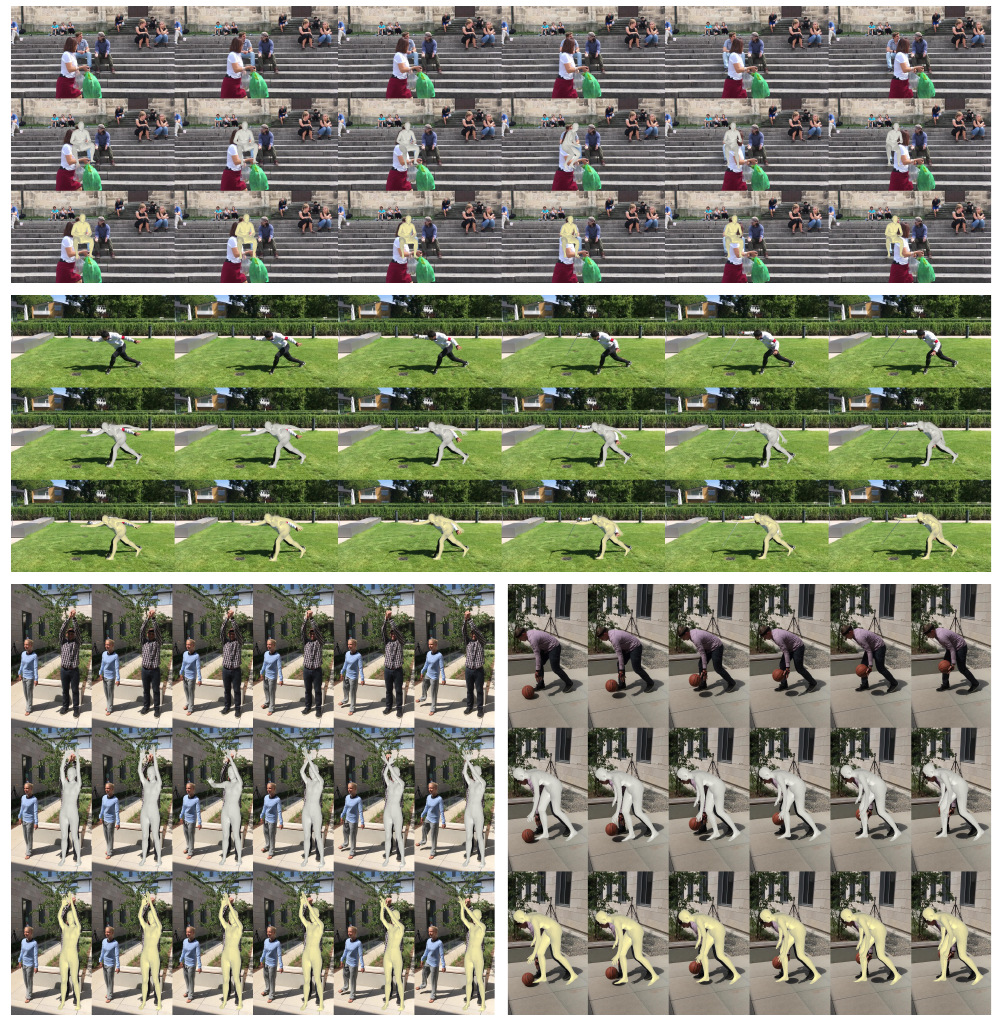
Figure 7. Input images ( top ) and reconstruction results of VIBE ( middle , gray SMPL mesh) and HPR-Net ( bottom , yellow SMPL mesh) on the 3DPW